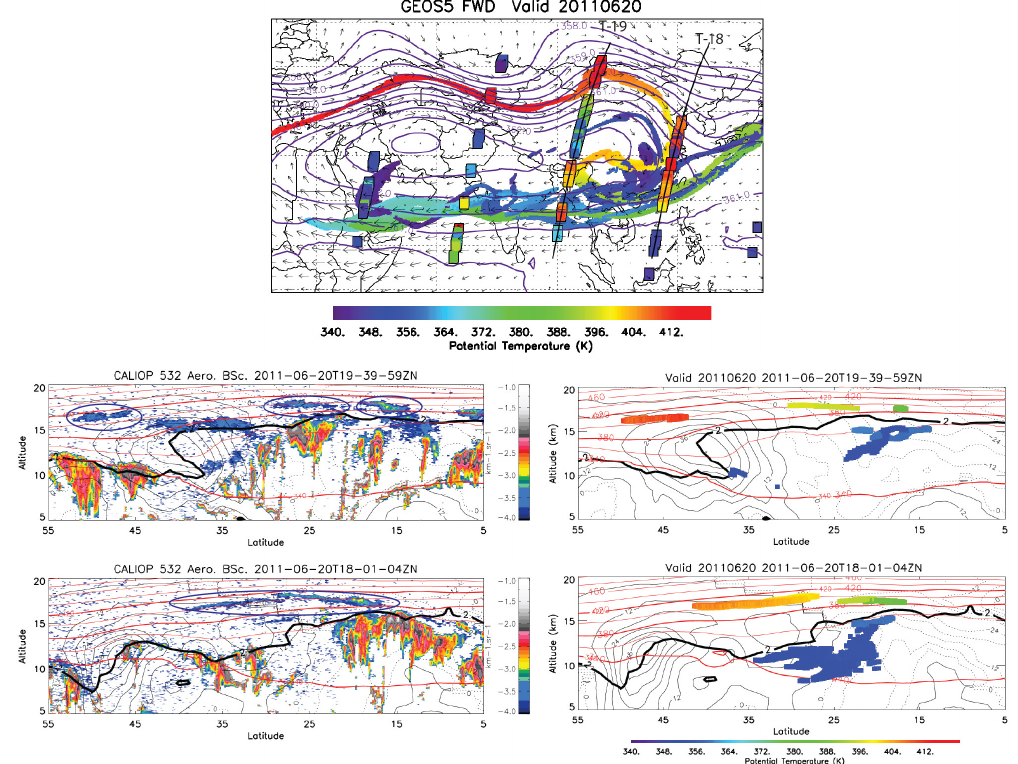
Figure 4. As for Fig. 3, but for 18:00Z–midnight on 20 June with 532nm attenuated aerosol backscatter curtains, and coincident trajectory curtains for CALIPSO nighttime orbits T19-39-59ZN and T18-01-04ZN, marked by black curves on map